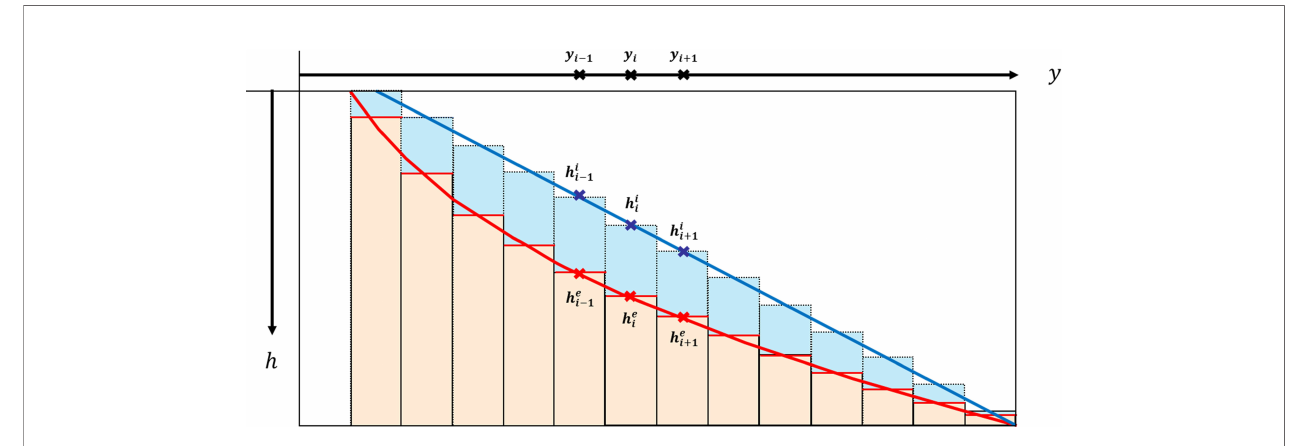
FIGURE 3 | Diagram of numerical calculation system in